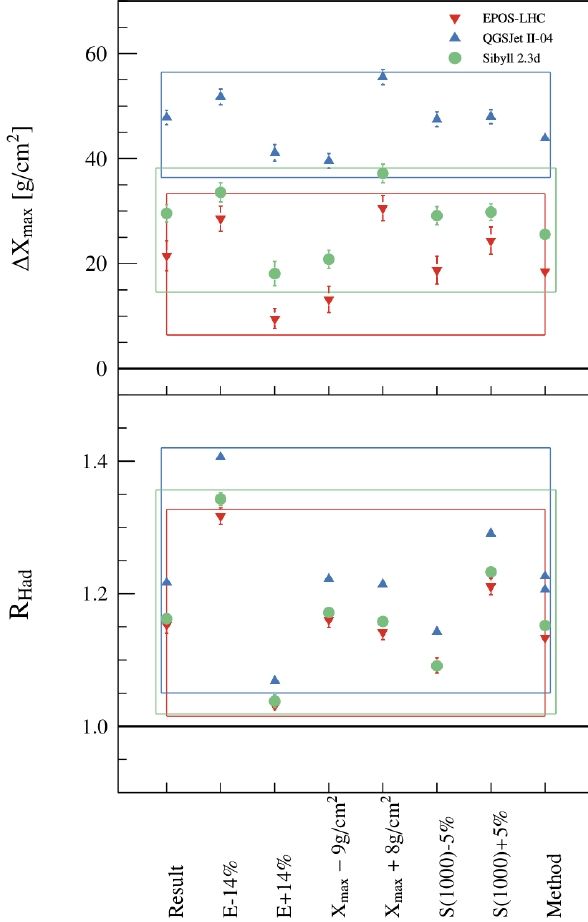
Figure 8: Individual systematic contributions (points) to the total systematic uncertainty (band) of R Had and ∆ X max